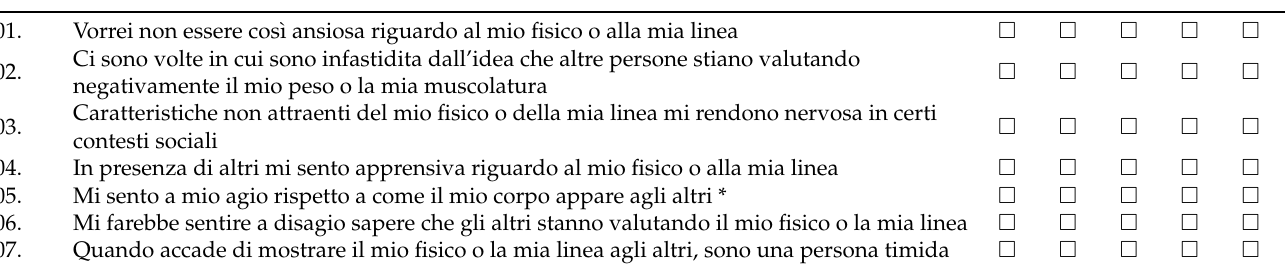
Table A4. List of items in the Italian